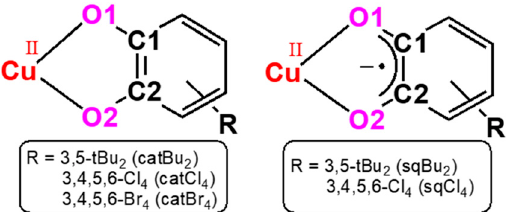
Scheme 3. Schematic drawing of two types of copper(II) complexes in Table 1. Table 1. Structural parameters of selected catecholato and o -semiquinonato copper(II) complexes.